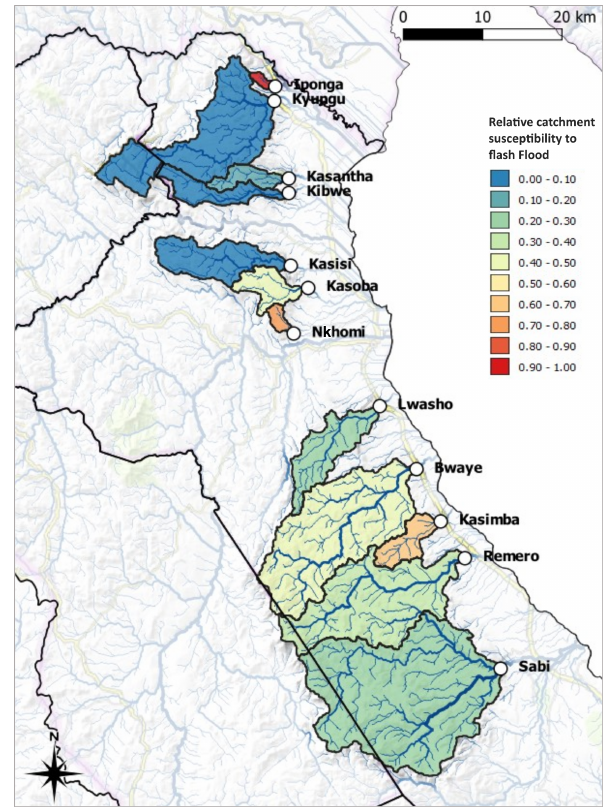
Figure 5. Relative flash flood susceptibility of the catchments in Karonga